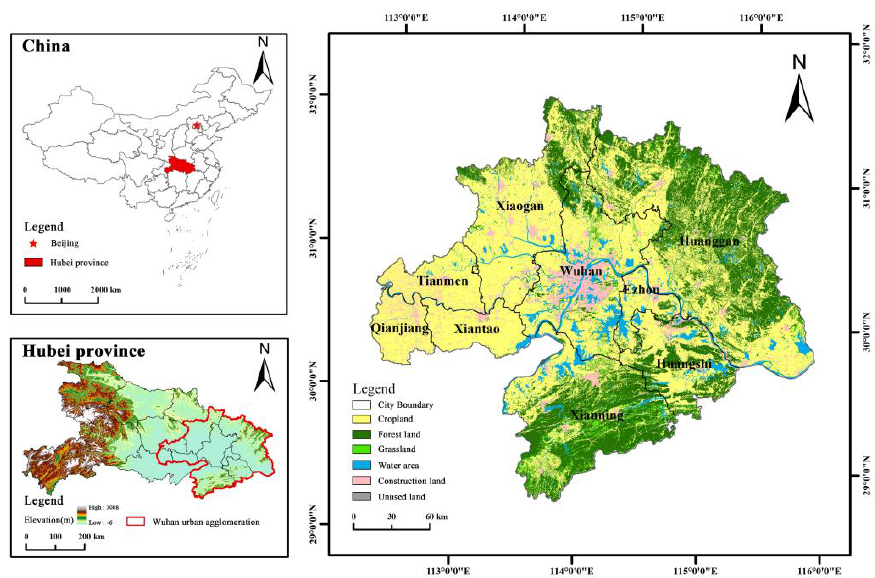
Figure 1. Location of the study area.